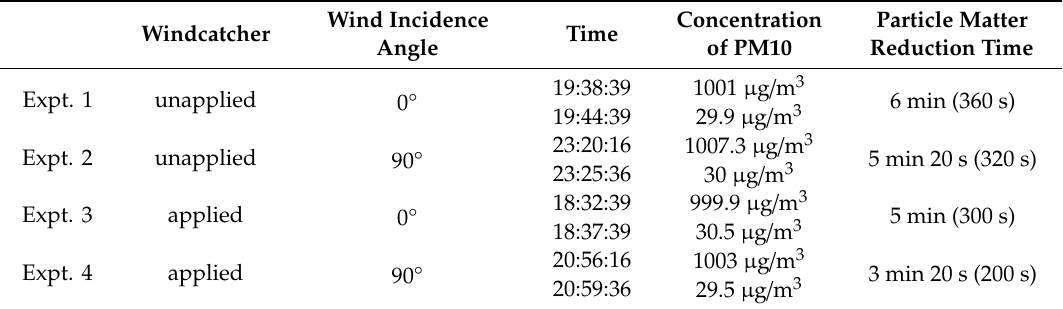
Table 7. Summary of the experimental results.